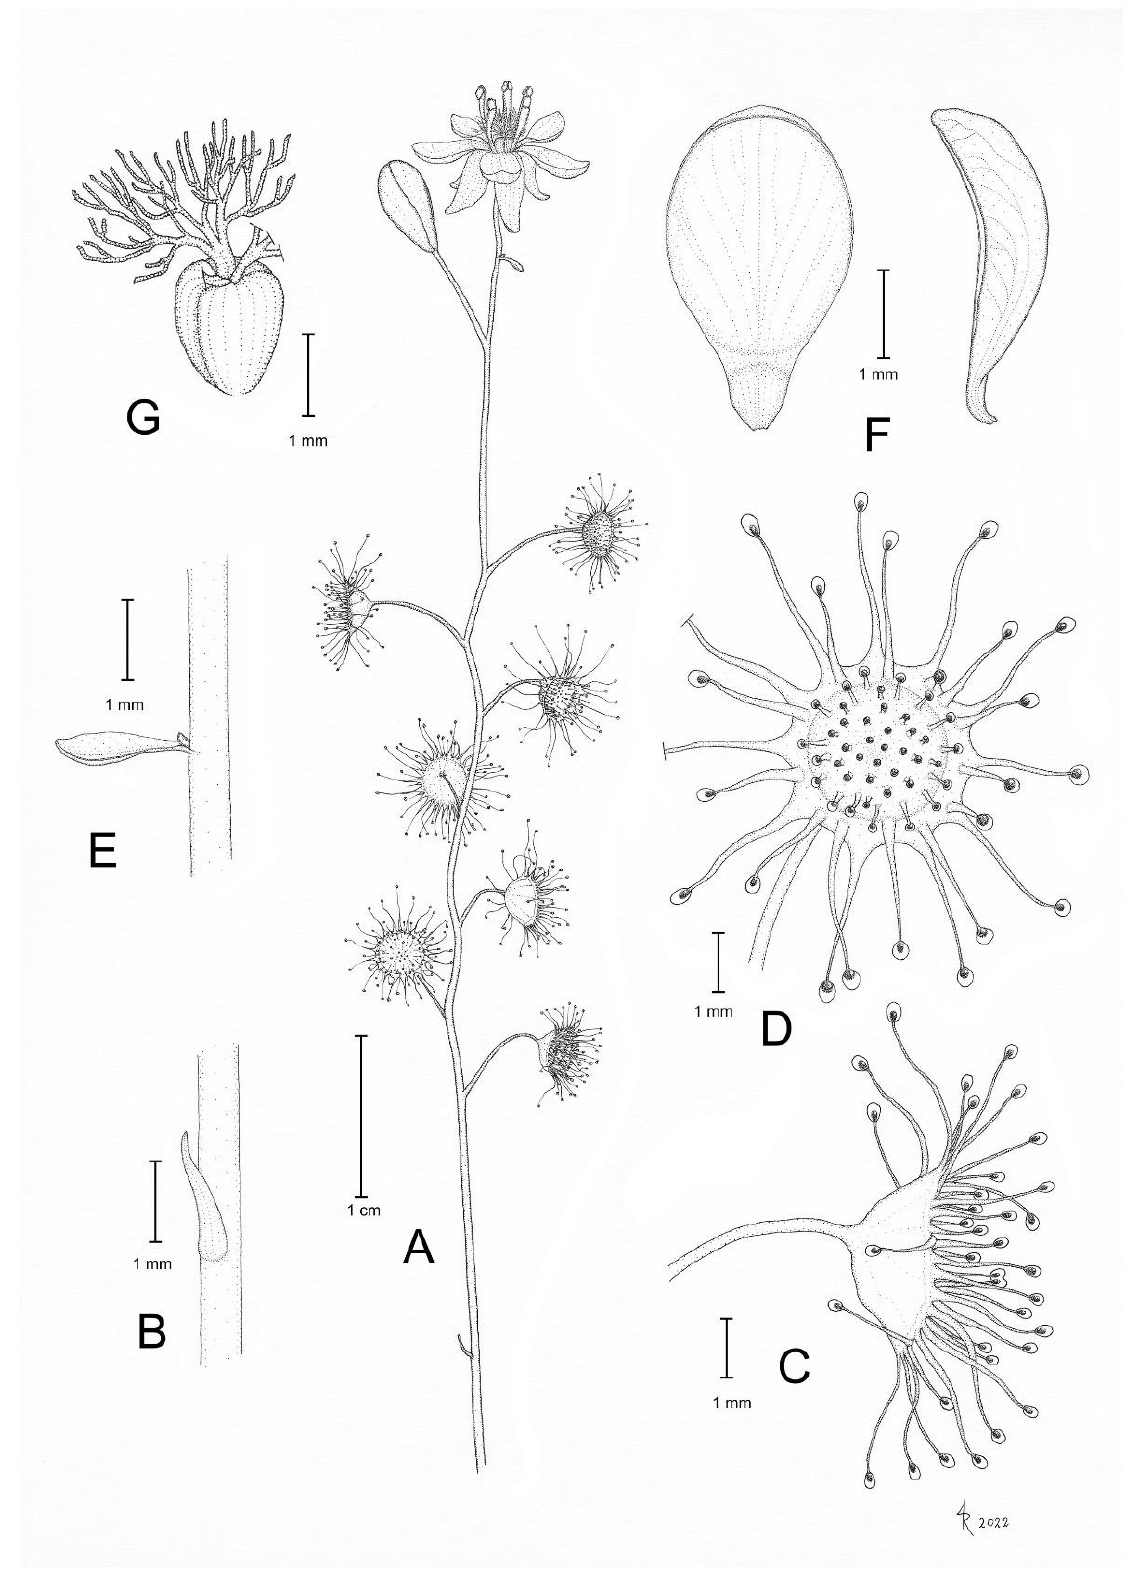
Figure 10. Drosera koikyennuruff T.Krueger & A.S.Rob. ( A ) habit; ( B ) cataphyll from stem base; ( C ) lamina, lateral view; ( D ) lamina, adaxial view; ( E ) bract; ( F ) petals, adaxial view (left), lateral view (right); and ( G ) gynoecium, with two styles removed. ( A , D – G ) from type and photographs of living plants and ( B ) from photographs of living plants only. Drawing: A. Robinson.